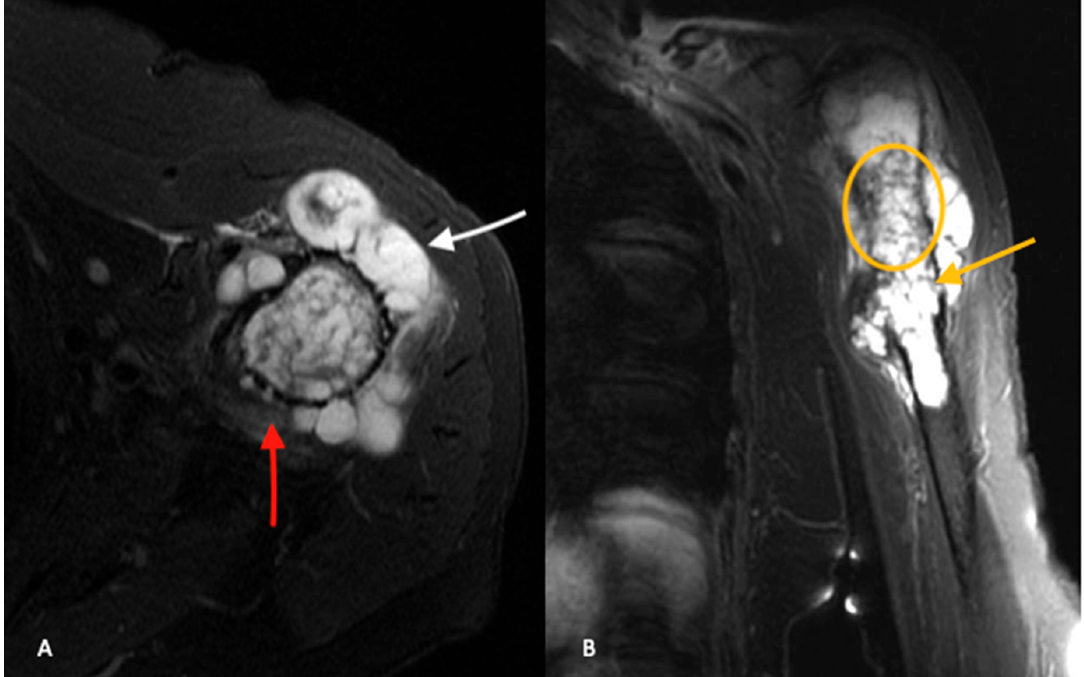
Figure 3. Axial ( A ) and coronal ( B ) T2-weighted, fat-saturated MR images of the same patient in Figure 2 confirm present of a chondroid lesion (yellow circle) with aggressive features, including cortical breakthrough (white arrow) and numerous areas of endosteal scalloping (yellow arrow). There is a significant amount of extra-osseous chondroid tumor. Perilesional edema (red arrow) is seen extending into the adjacent soft tissues.